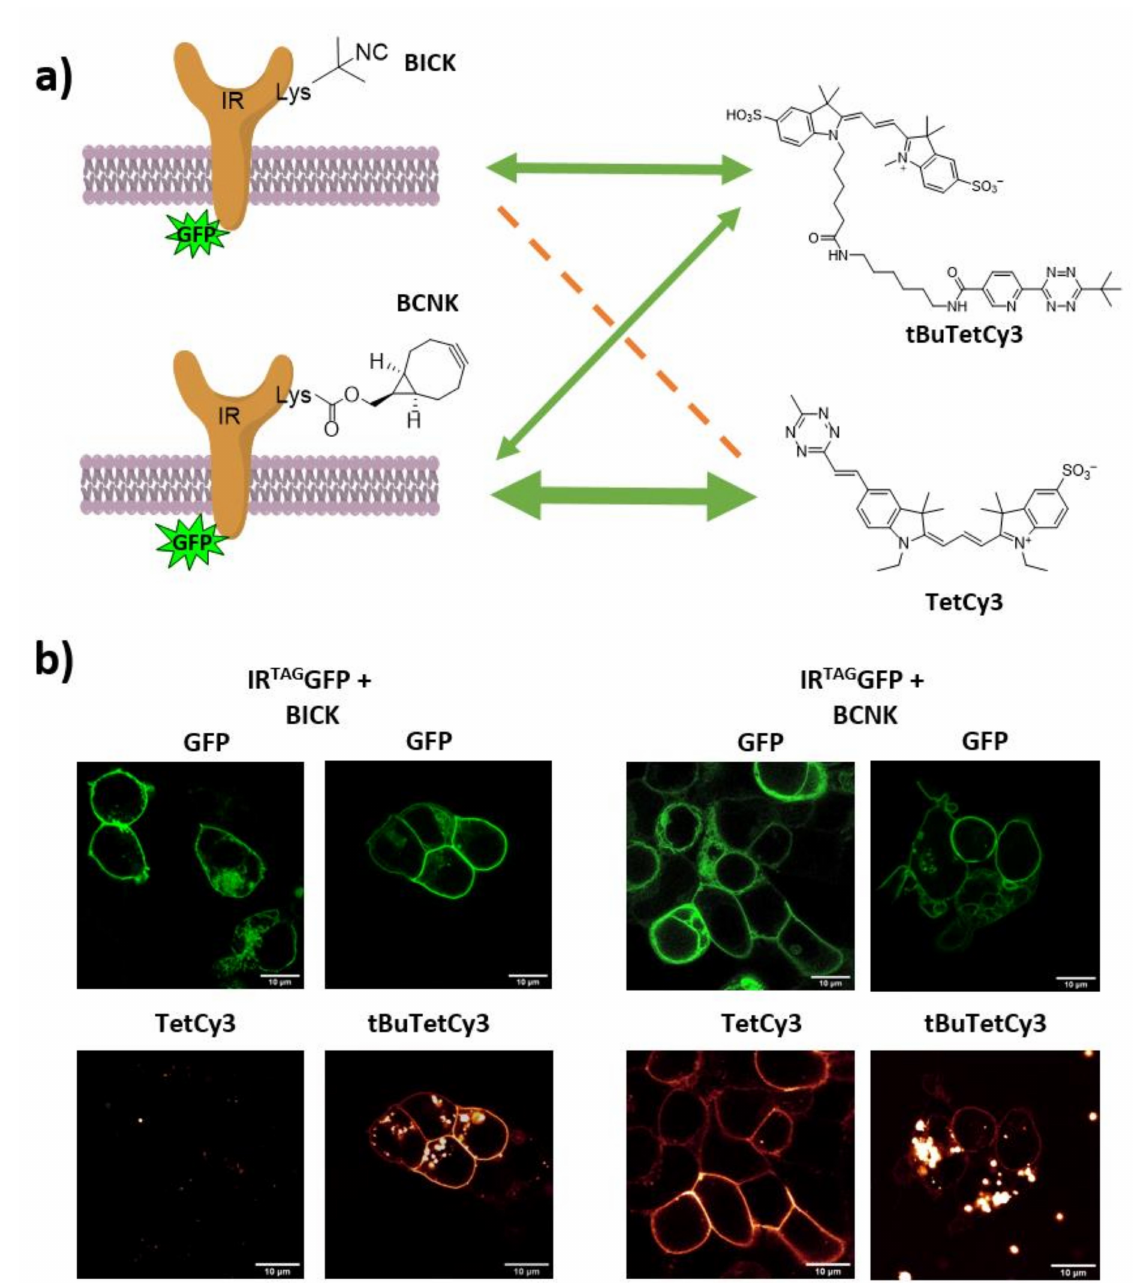
Figure 4. ( a ) Live cell bioorthogonal labeling scheme of overexpressed insulin receptor-GFP fusion protein (IR TAG GFP) in HEK293T cells with incorporation of either of the ncAAs BICK or BCNK and testing the labeling efficiency of a tertbutyl- tetrazine conjugated dye ( tBuTetCy3 ) and a tetrazine conjugated dye ( TetCy3 ). ( b ) Confocal images of the live cell labeling experiment outlined in the scheme in ( a ). We tested the orthogonality in cellulo of the bioorthogonal reactions between the ncAAs BICK (1 mM) or BCNK (250 µ M) genetically incorporated into IR TAG GFP and labeled with tBuTetCy3 (100 µ M, overnight) or TetCy3 (3 µ M, 60 min). Detection windows: green channel (GFP) 495–550 nm; red channel ( tBuTetCy3 and TetCy3 conjugate) 565–650 nm. False colour codes: Green: The reporter fluorophore GFP shows location of efficient IR expression. Red: Labeling of IR with tBuTetCy3 and TetCy3 . Scale bar = 10 µ